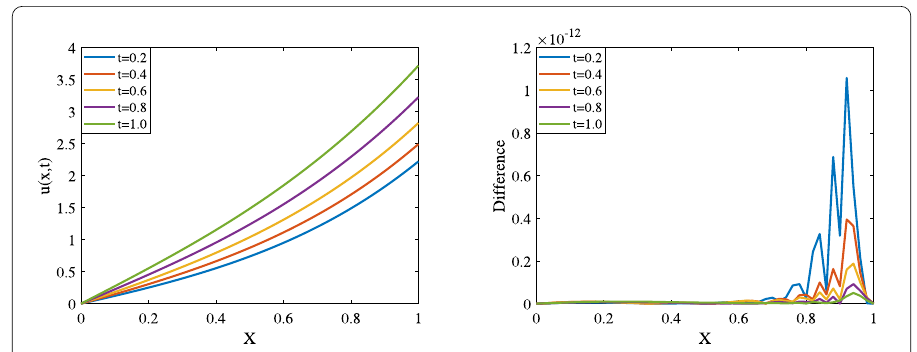
Figure 4 The figures of solutions of R-CFDS4(left) and difference(right) between R-CFDS4 and CFDS4 with h = 0.02 and τ = 0.01 for SP 2